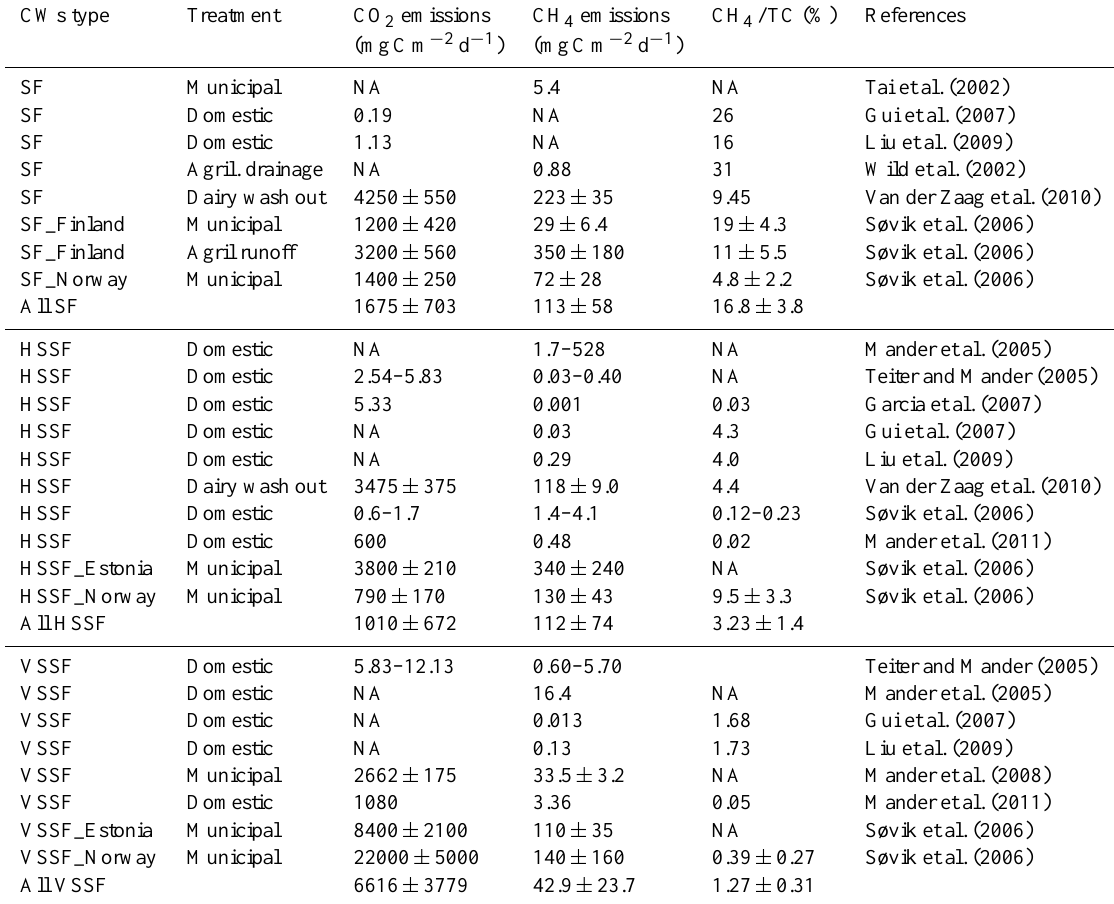
Table 4. Carbon dioxide (CO 2 ; mgCm − 2 d − 1 ), CH 4 (mgCm − 2 d − 1 ), and CH 4 emission factor (CH 4 –C / TOC input × 100) in various types of CWs; mean standard error ( ± SE) was presented for CH 4 emission factor; NA – data not